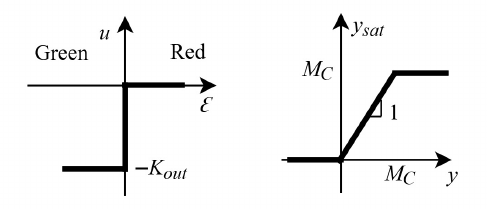
Figure 6. Nonlinear components.